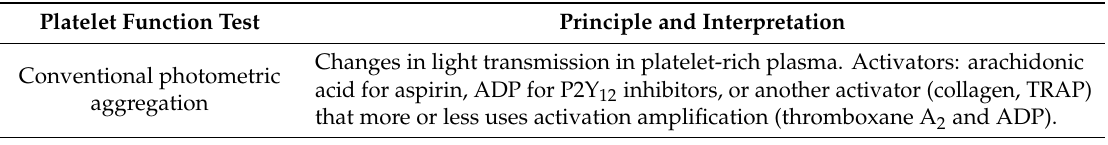
Table 1. Succinct description of the main platelet function tests used for the in vitro evaluation of the e ff ects of antiplatelet therapy; adapted from [33], with